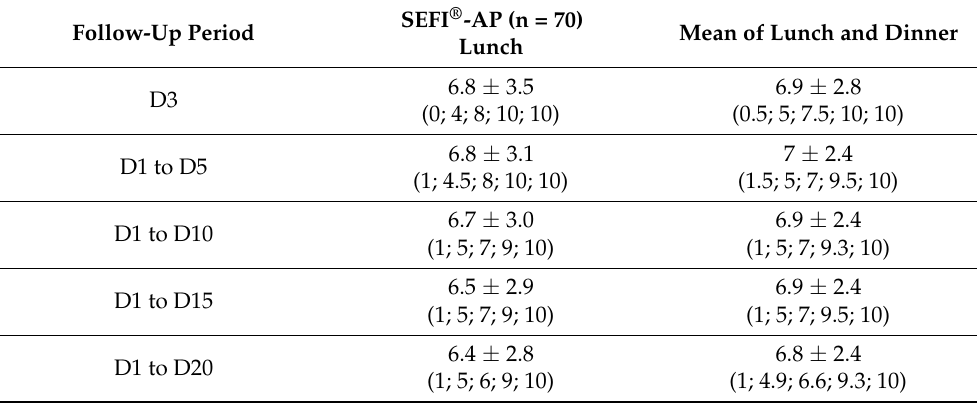
Table 3. Median values of the Simple Evaluation of Food Intake ® assisted by photography (SEFI ® -AP) evaluated from lunch or lunch + dinner according to the follow-up period.